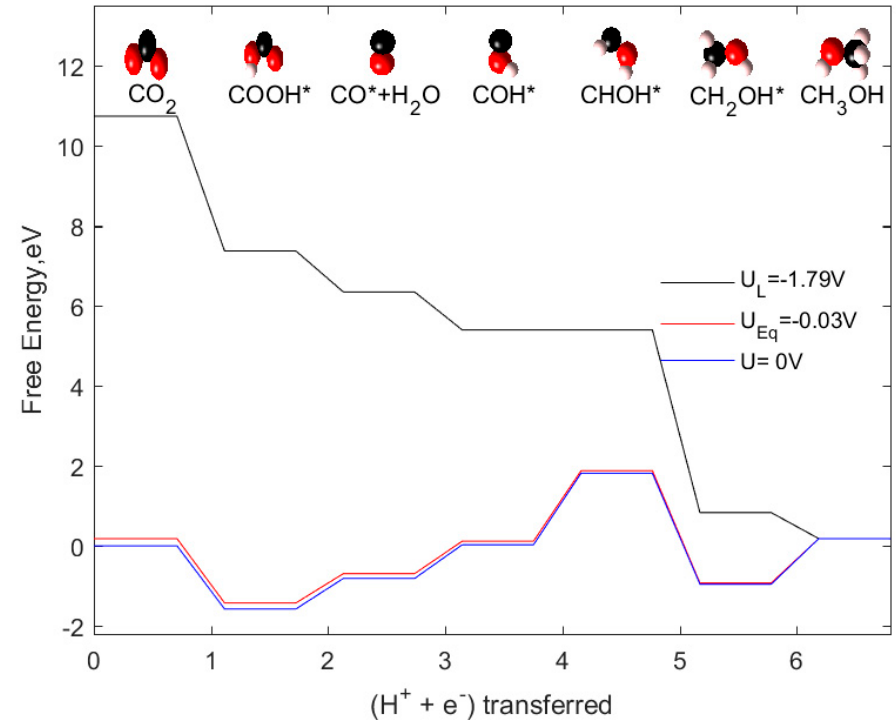
Figure 6. Reaction energy profiles for CO 2 reduction to CH 3 OH at 0 V vs. RHE (blue), thermodynamic limiting potential of (U L ) − 1.79 V vs. RHE (black) and equilibrium potential (U E ) of − 0.03 V vs. RHE (red). Color code of atoms: red: oxygen, black: carbon, white: hydrogen.